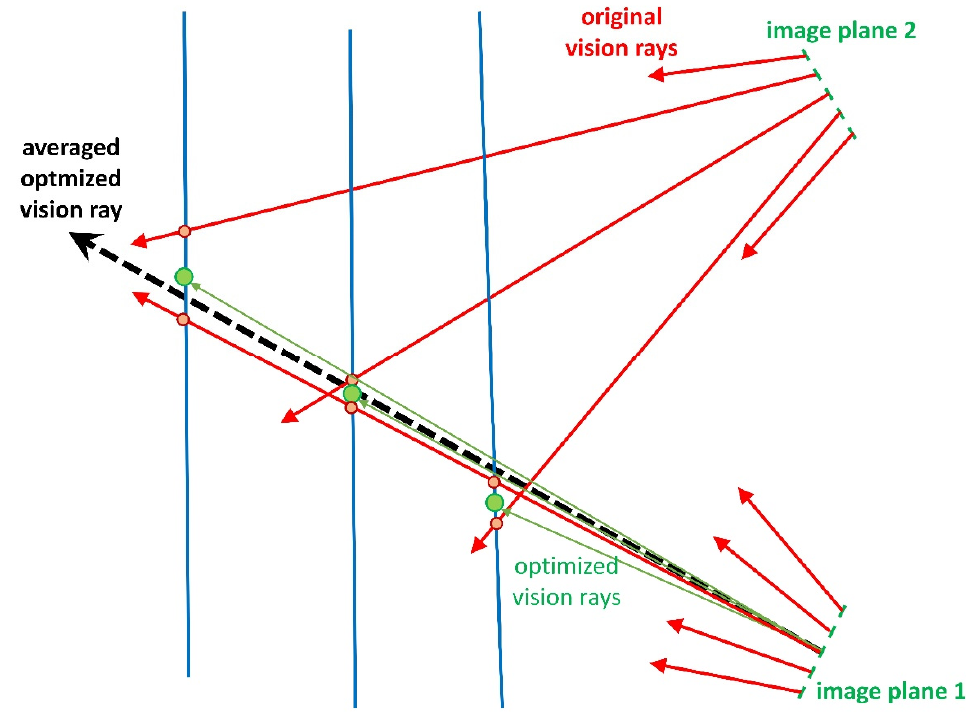
Figure 6. Different distances of ray manipulation corresponding to the same pixel of camera 1 leading to a weighted (dashed) ray.